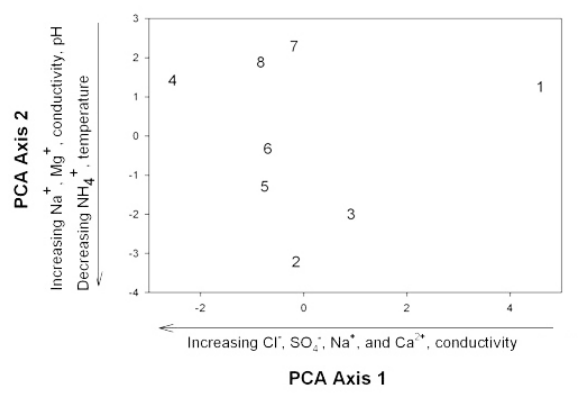
Fig. 5 . Principal Component Analysis (PCA) of study sites based on water physicochemistry. Axis 1 explained 34.1% of the variance and axis 2 explained an additional 32% of the variance. Numbers refer to study sites as in Table